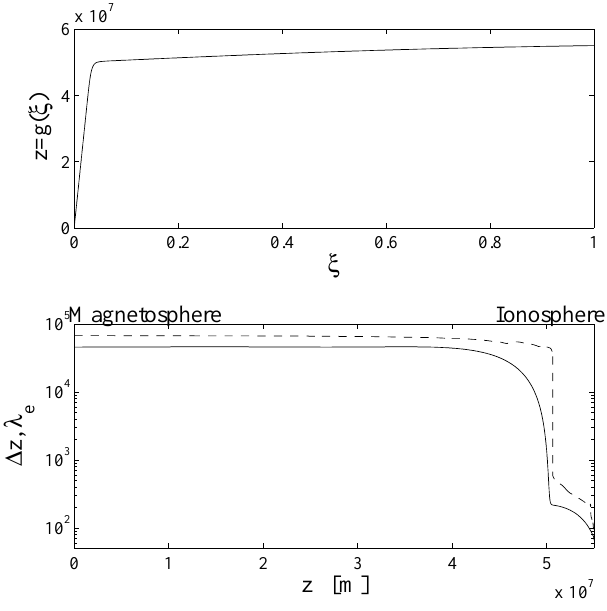
Fig. 2. An example of a transform: z = g(ξ) (top) and the resulting step size 1z (solid line) and the effective electron Debye length λ e (dashed line), from a simulation, as functions of z (bottom).